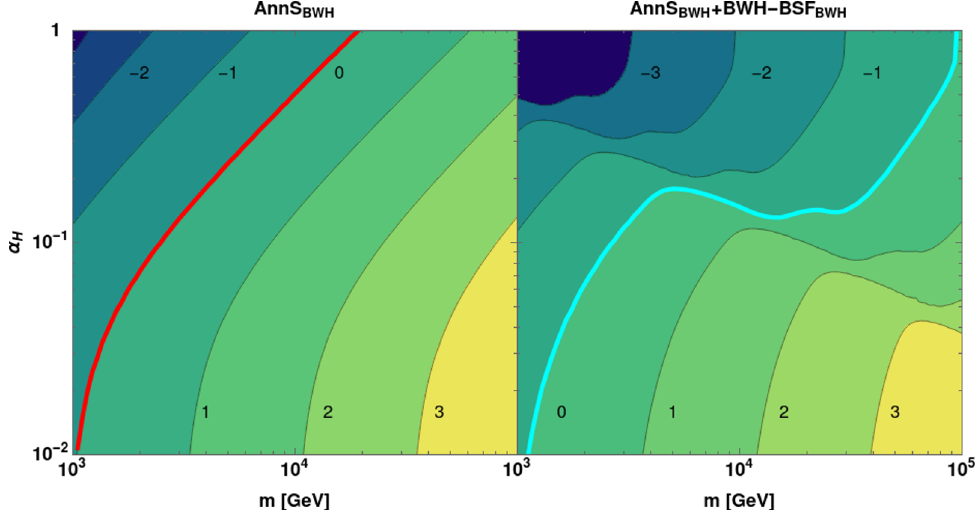
(Ω / Ω ) (with the values indicated in black), when considering DM 10 + BWH − BSF ( right ). The red and cyan lines mark BWH BWH √ = m − 4 πα , differs significantly from m only at DM H v H